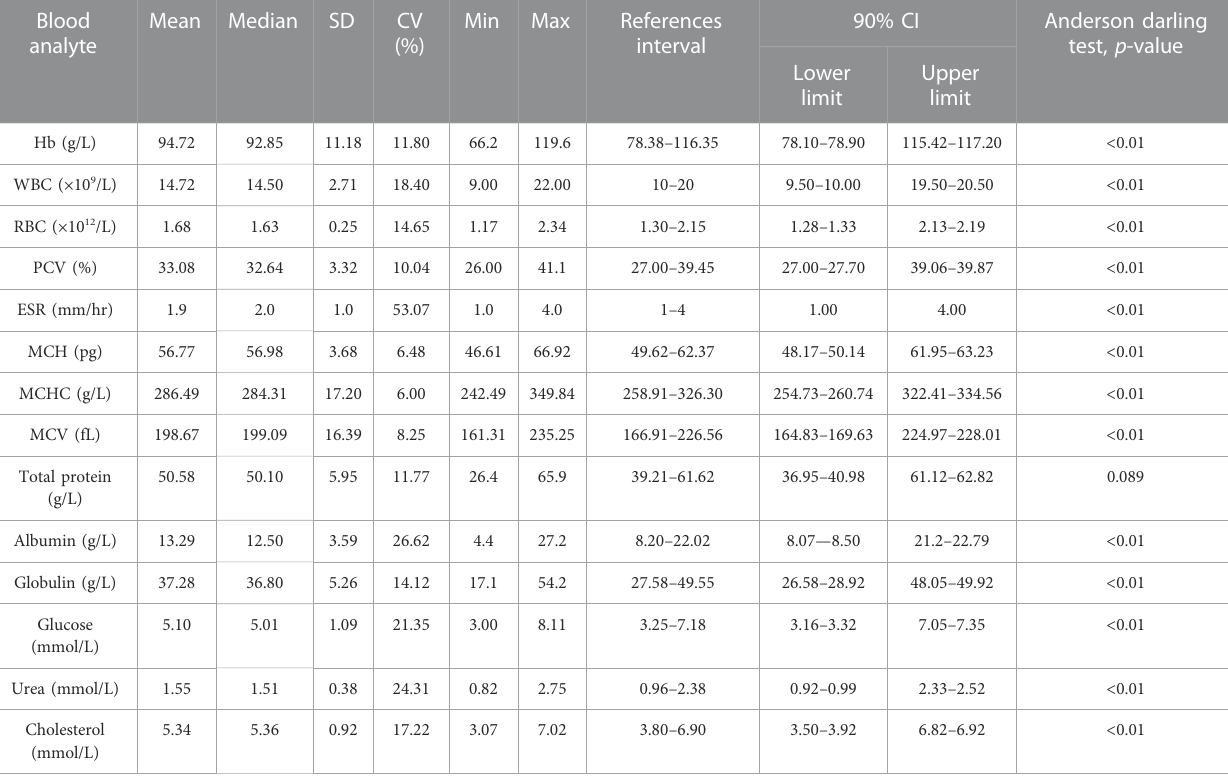
TABLE 2 Hematology and serum biochemical reference intervals for snow trout, Schizothorax esocinus from River Jhelum. Reference intervals were determined using reference value advisor software following non-parametric method for all measurands ( p < 0.05) and robust method ( p > 0.05) for total protein. Blood